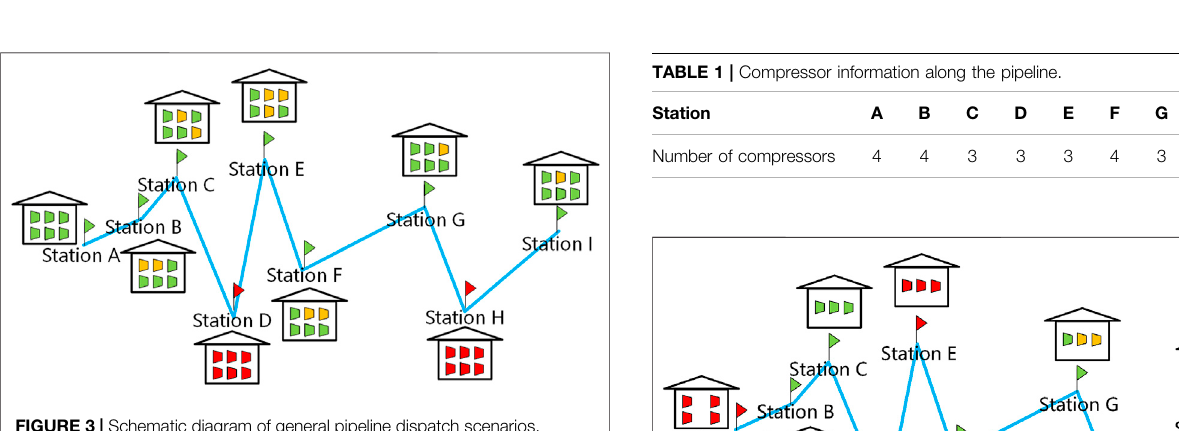
FIGURE 3 | Schematic diagram of general pipeline dispatch scenarios.